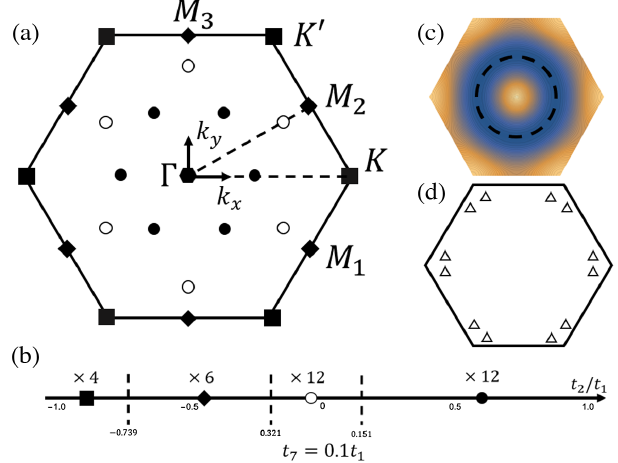
FIG. 2. (a) The minima of the vortex band structure. With nearest neighbor vortex hopping on Fig. 1, the minima locate at the K and K 0 points of the Brillouin zone, each K point has two fold degeneracy; with further neighbor hoppings, the minima can shift to the three M points, still with twofold degeneracy at each M point. (b) The phase diagram of vortex modes with seventh neighbor hopping t 7 ¼ 0 . 1 t 1 , and by tuning t 2 there are two regions in the phase diagram with N ¼ 12 vortex modes at low energy. The 12 vortex modes are located on the lines between either Γ and K=K 0 or Γ and M . (c) With only t 1 and t 2 , there is a large region of the phase diagram where there is a ring degeneracy of the vortex band structure. (d) All the symmetries (including approximate symmetries) of the system can protect up to 24 degenerate vortex modes, which locate at 12 incommensu- rate momenta in the